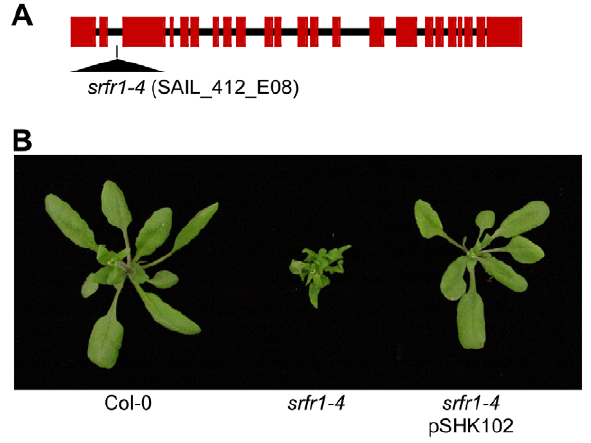
Figure 1. A mutation in SRFR1 causes severe stunting in Col-0. (A) Schematic gene structure of SRFR1 (At4g37460), with exons shown as boxes and introns as lines. The T-DNA insertion site in the second intron in srfr1-4 (SAIL_412_E08) is indicated. (B) Growth phenotype of srfr1-4 and complementation with a genomic copy of SRFR1 in transgenic plants.